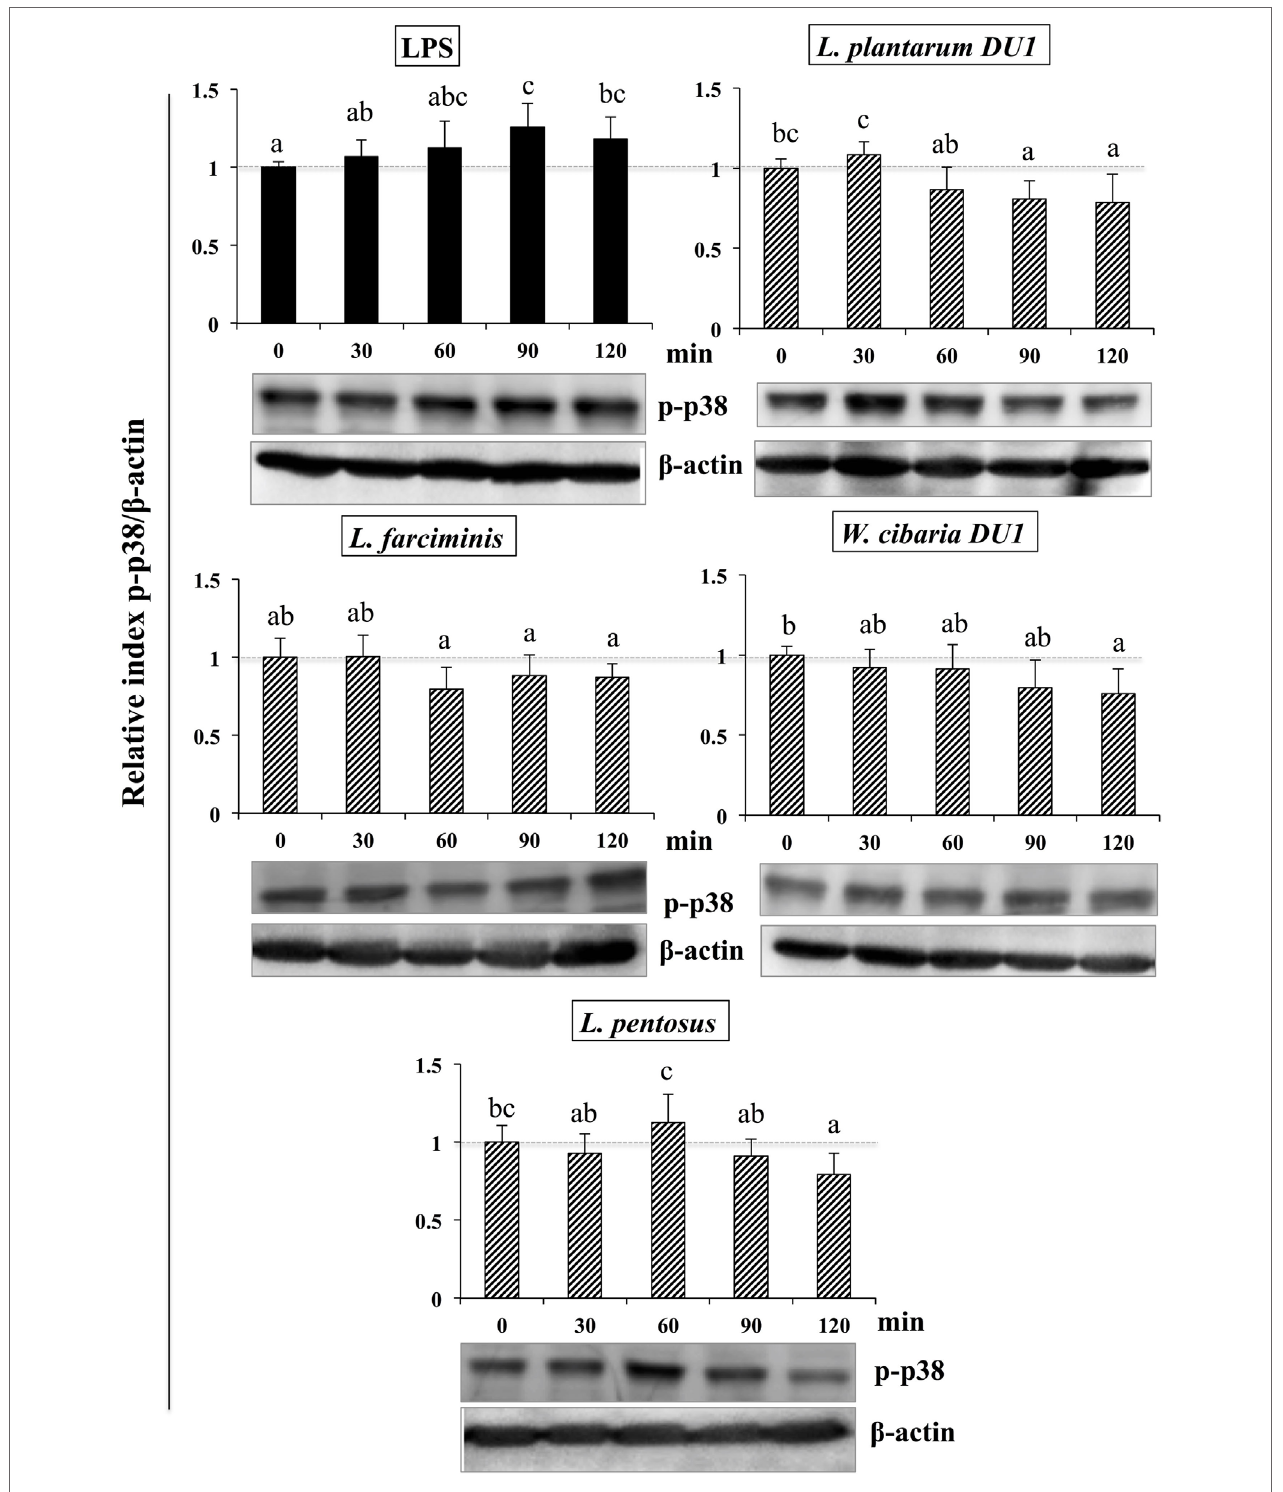
FigUre 8 | Total cellular fluid (TCF) of lactic acid bacteria (LABs) downregulated expression of p38 mitogen-activated protein kinase (MAPK) in hepatoma HepG2 cells. Confluence HepG2 cells were pre-stimulated with LABs TCF (50 µl/ml) for 48 h, then stimulated with LPS for different time intervals (0, 30, 60, 90, and 120 min). Western blot was performed to determine the phosphorylation of p38 MAPK at the indicated time points. The bar graphs represent the results of three independent experiments. The image J software was used to determine the intensities of proteins bands. Different superscript letters indicate significant differences at the 0.05